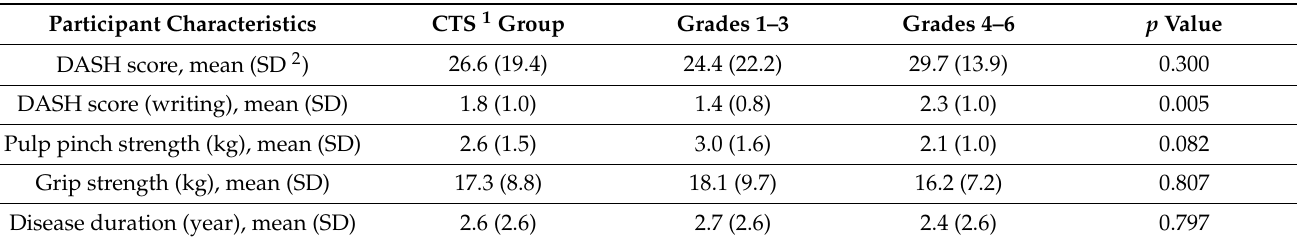
Table 3. Characteristics of participants in the CTS group, CTS grades 1–3, and grades 4–6.